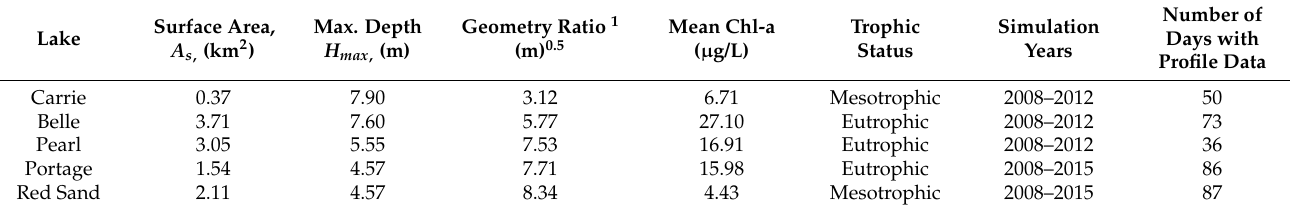
Table 1. Characteristics of five study lakes in